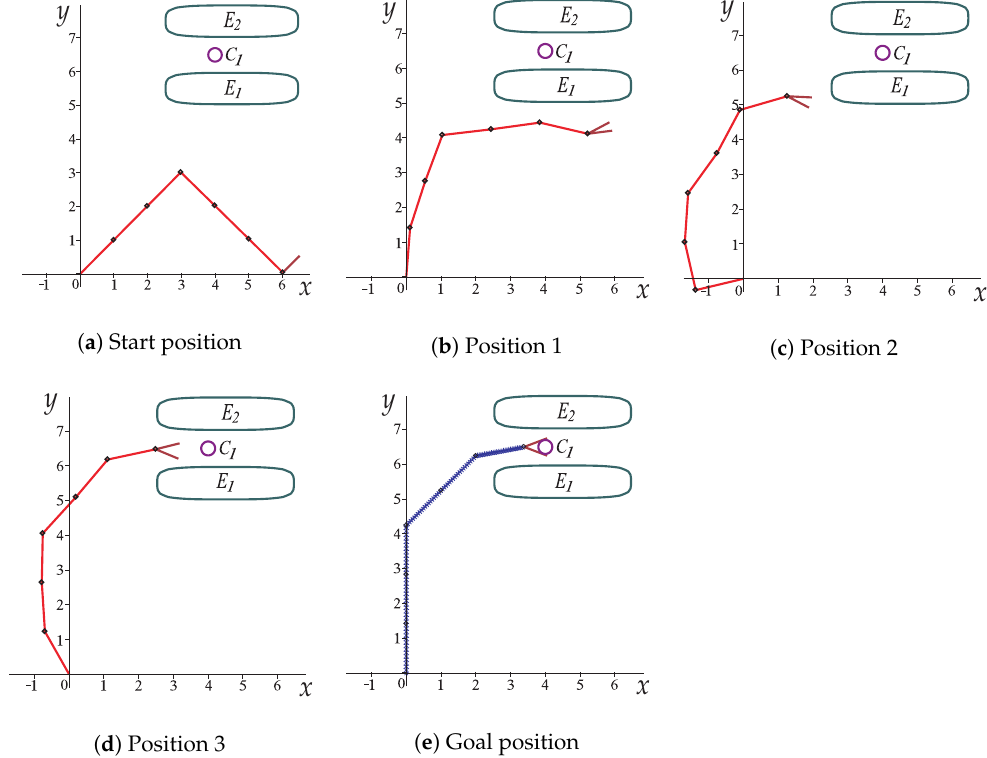
Figure 15. Movement of a six-link planar robot arm with a gripper, obstacles, and a circular object to grip.